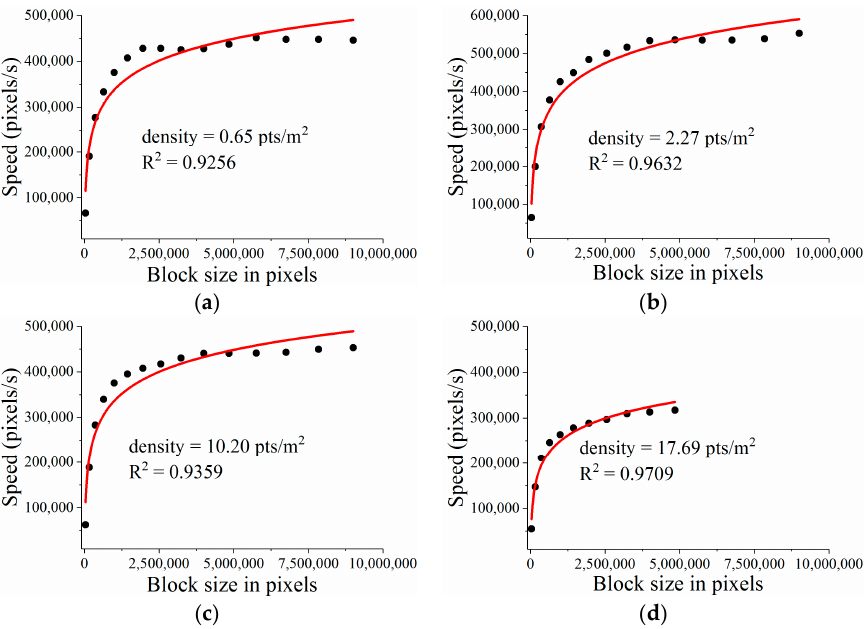
Figure 4. GPU processing speed (pixels per second) for different block sizes. ( a ) sample data 1; ( b ) sample data 2; ( c ) sample data 3; ( d ) sample data 4.